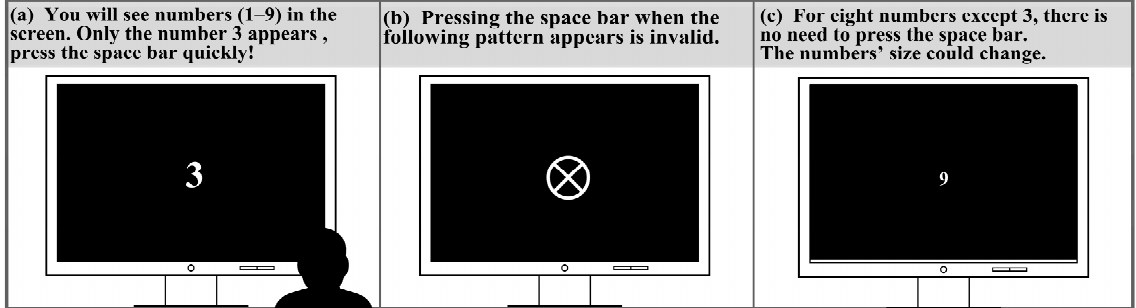
Figure 8. The process of the sustained attention to response test. The following variables were